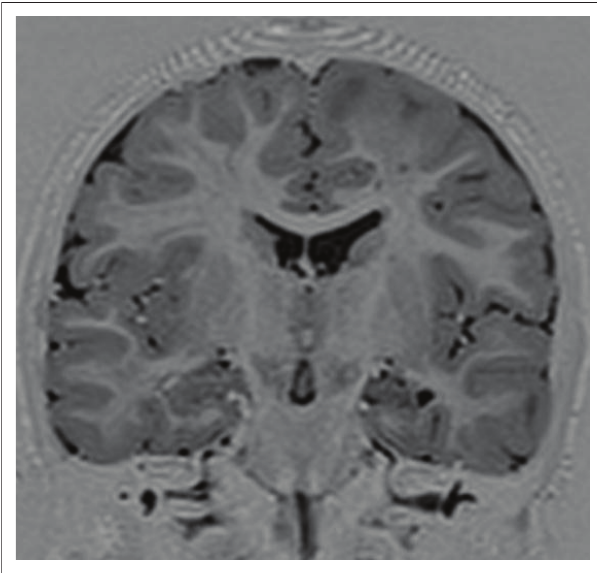
FIGURE 6: Coronal T1 inversion recovery MR image.